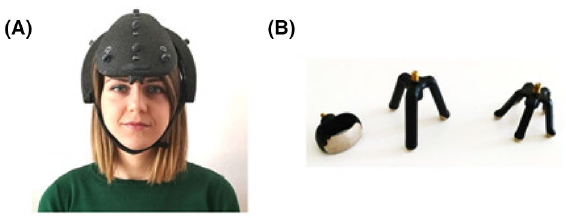
Figure 5. ( A ) EEG data acquisition system Helmate8 and ( B ) dry electrodes from abmedica